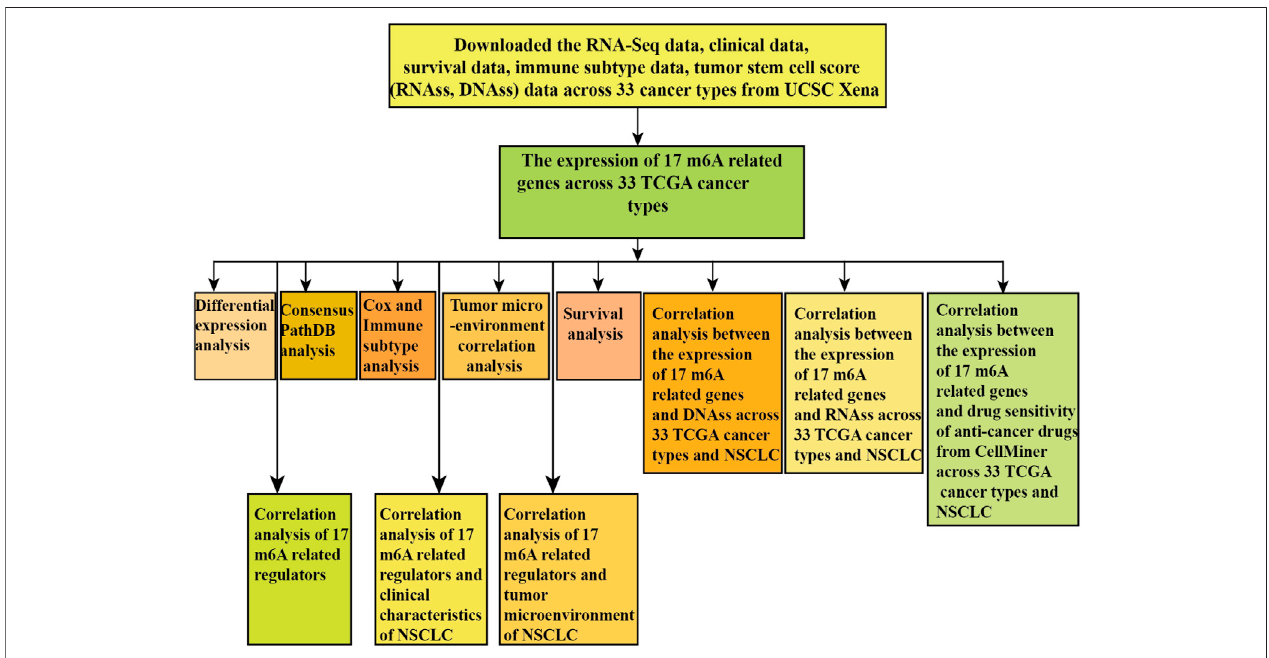
FIGURE 3 | Flowchart of the pan-cancer analysis of m6A methylation